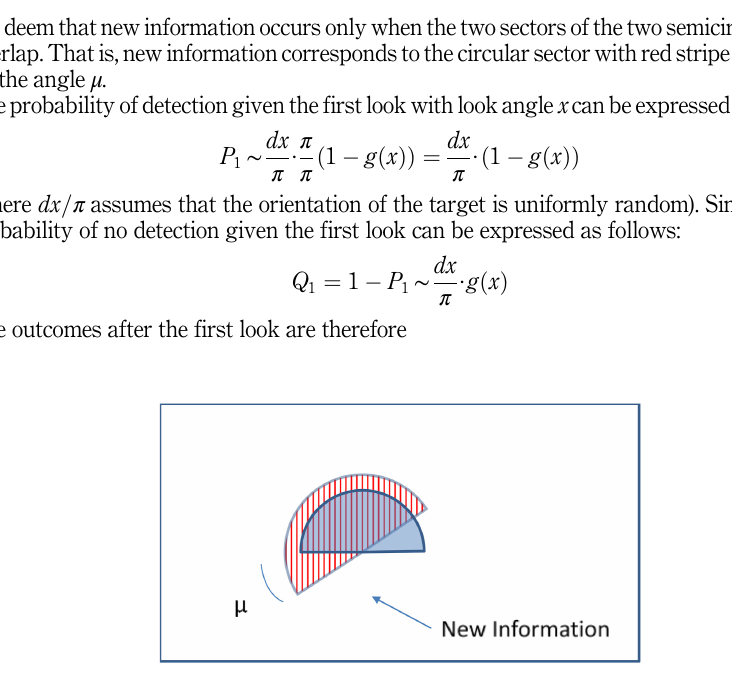
tothebluesemicircle.Thediameterofthebluesemicircleis ð 1 − g ð x ÞÞ while the diameter of the red semicircle is equal to 1. Therefore, the diameter of the red semicircle is always greater than or equal to the diameter of the blue